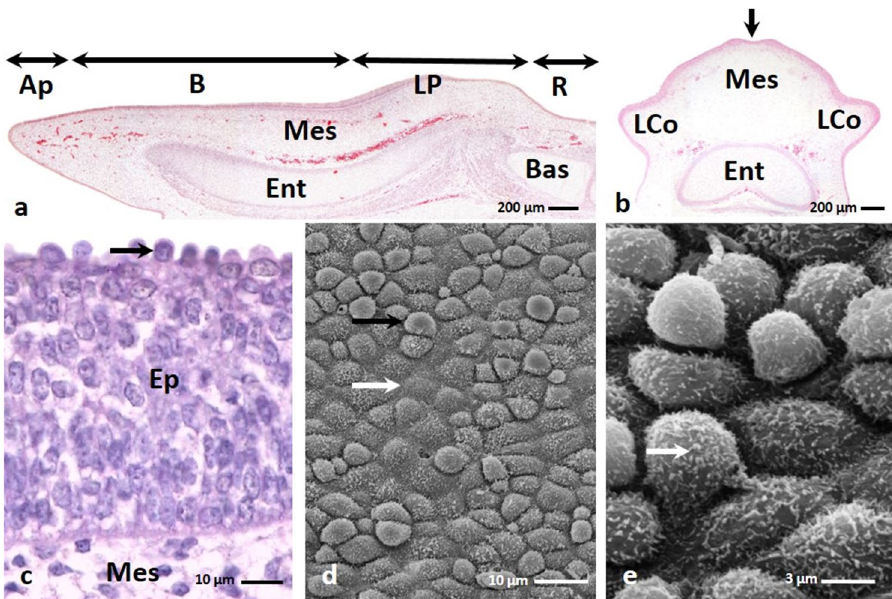
Figure 1. ( a ) 14th day of incubation. Cross section along the long axis of the tongue composing of the apex (Ap), body (B), raised lingual prominence (LP) and root of the tongue. Inside the tongue the primordium of the entoglossum cartilage (Ent) and basyhiale bone (Bas) are visible. Mes-mesenchyme. LM. Masson–Goldner staining. ( b ) 14th day of incubation. Transverse cross section of the lingual prominence with a shallow recess in the middle (arrow). On the side of the lingual prominence are visible primordia of the large conical papillae (LCo). Ent-entoglossum cartilage, Mes-mesenchyme. LM. Masson–Goldner staining. ( c ) 12th day of incubation. Cross section of the embryonic epithelium (Ep) on the lingual prominence. Violet colored cell nuclei of the superficial cells are present (arrow). Mes-mesenchyme. LM. Masson–Goldner staining. ( d ) 12th day of incubation. The surface of the lingual prominence epithelium with convex superficial cells (black arrow) and flat superficial cells (white arrow). SEM. ( e ) 12th day of incubation. Higher magnification of the surface of epithelial cells with numerous microvilli (arrow).